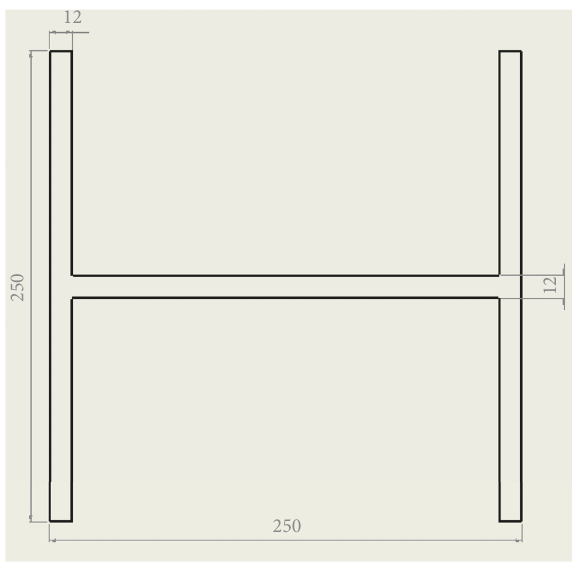
Figure 4: Cross section view of bracket (mm).